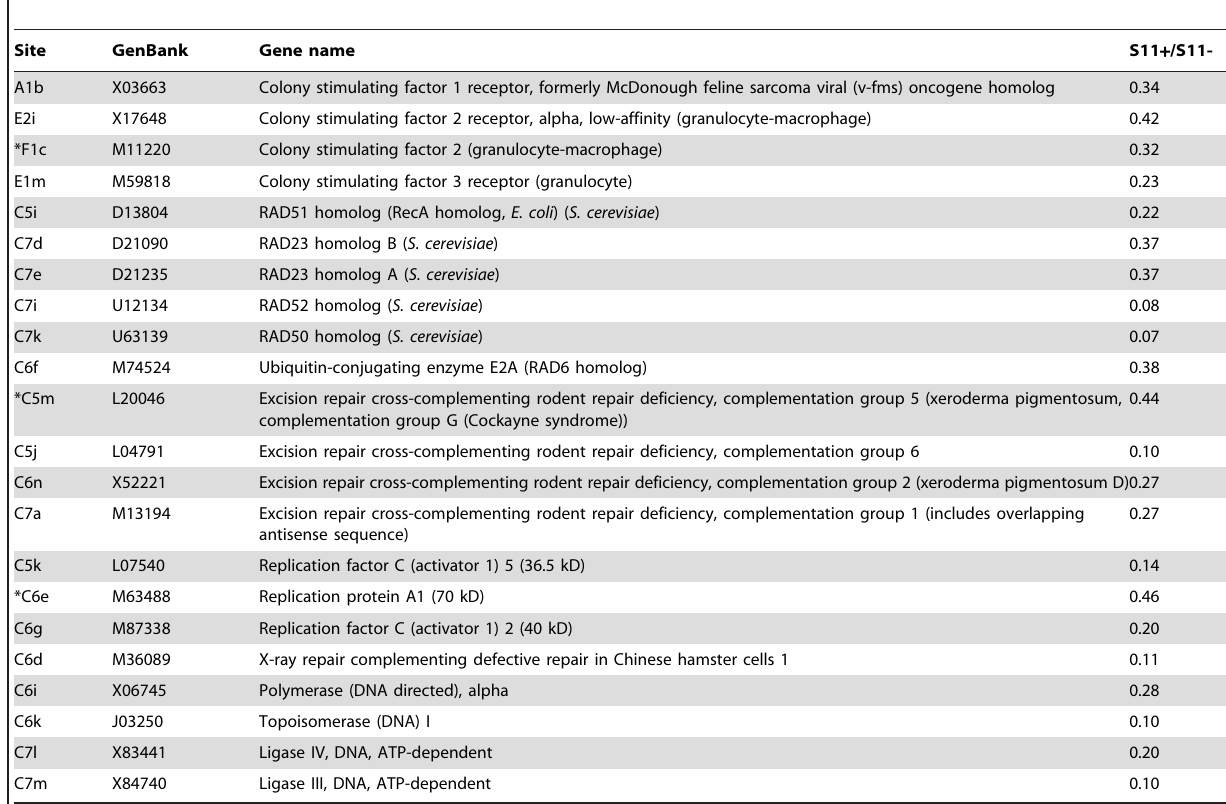
Table 3. Genes decreased in Hep3B-tet on-FN1BP1/S11 cells induced by Dox (* selected to identify by RT-PCR).